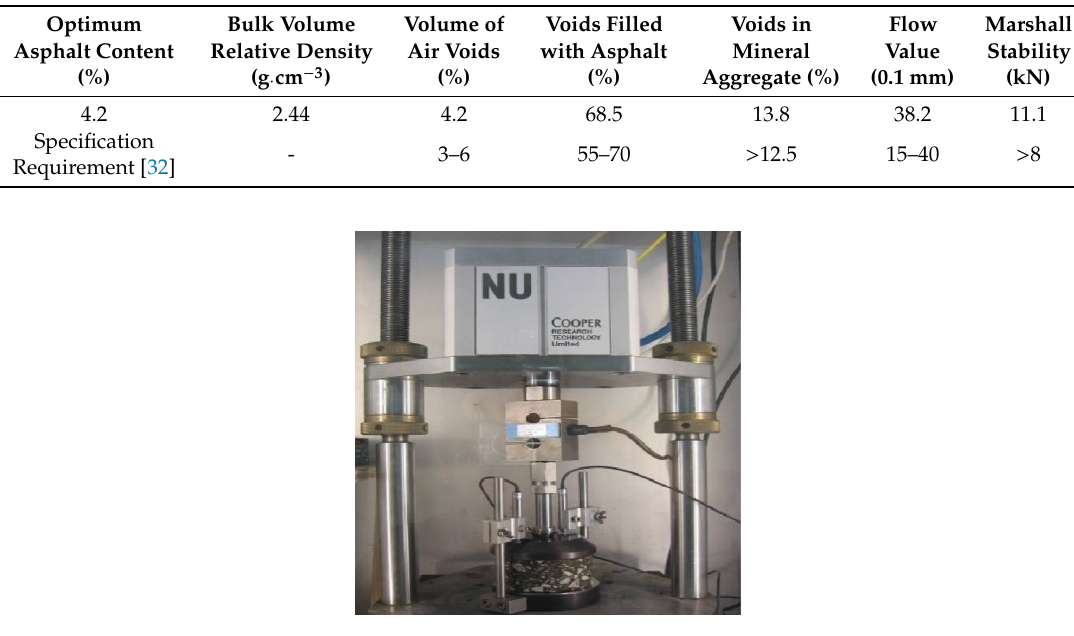
Table 3. Characteristics of asphalt mixture.